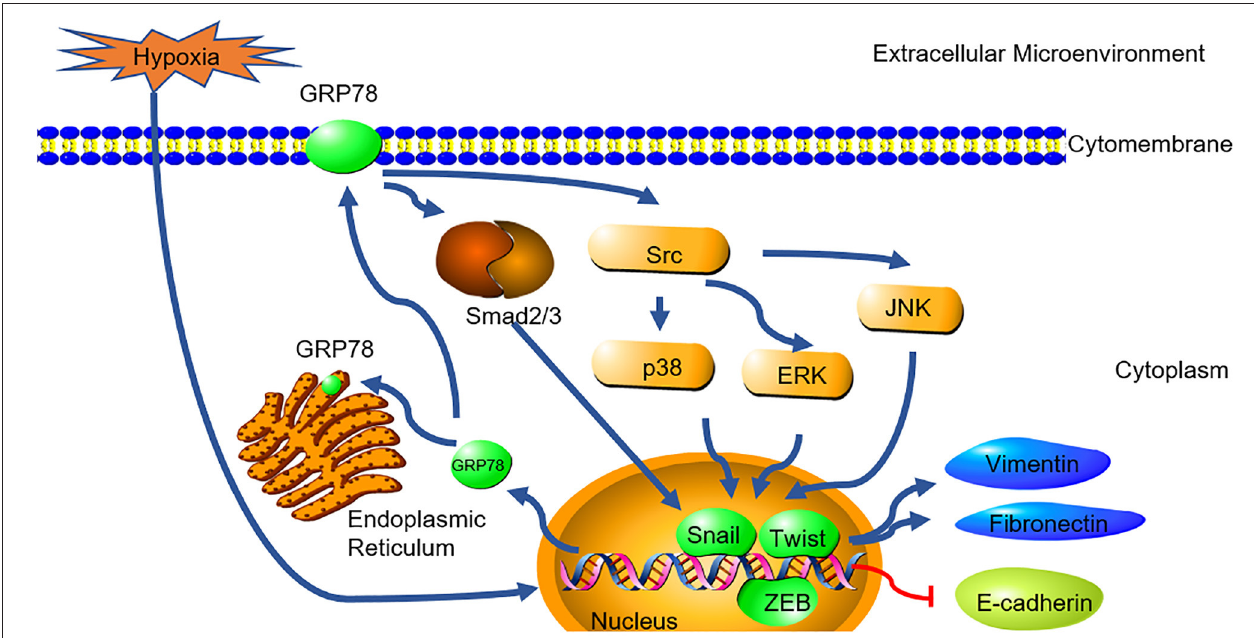
FIGURE 5 | GRP78 mediates hypoxia-induced EMT through smad2/3 and SRC/MAPK signaling. Hypoxia induced the high expression of GRP78. High expressed GRP78 activated the smad2/3 and Src/MAPK pathway. The pathway activated the expression of EMT transcription factor (snail, Twist and ZEB) and collaborated with them to induce the expression of Fibronectin, Vimentin and inhibit the expression of